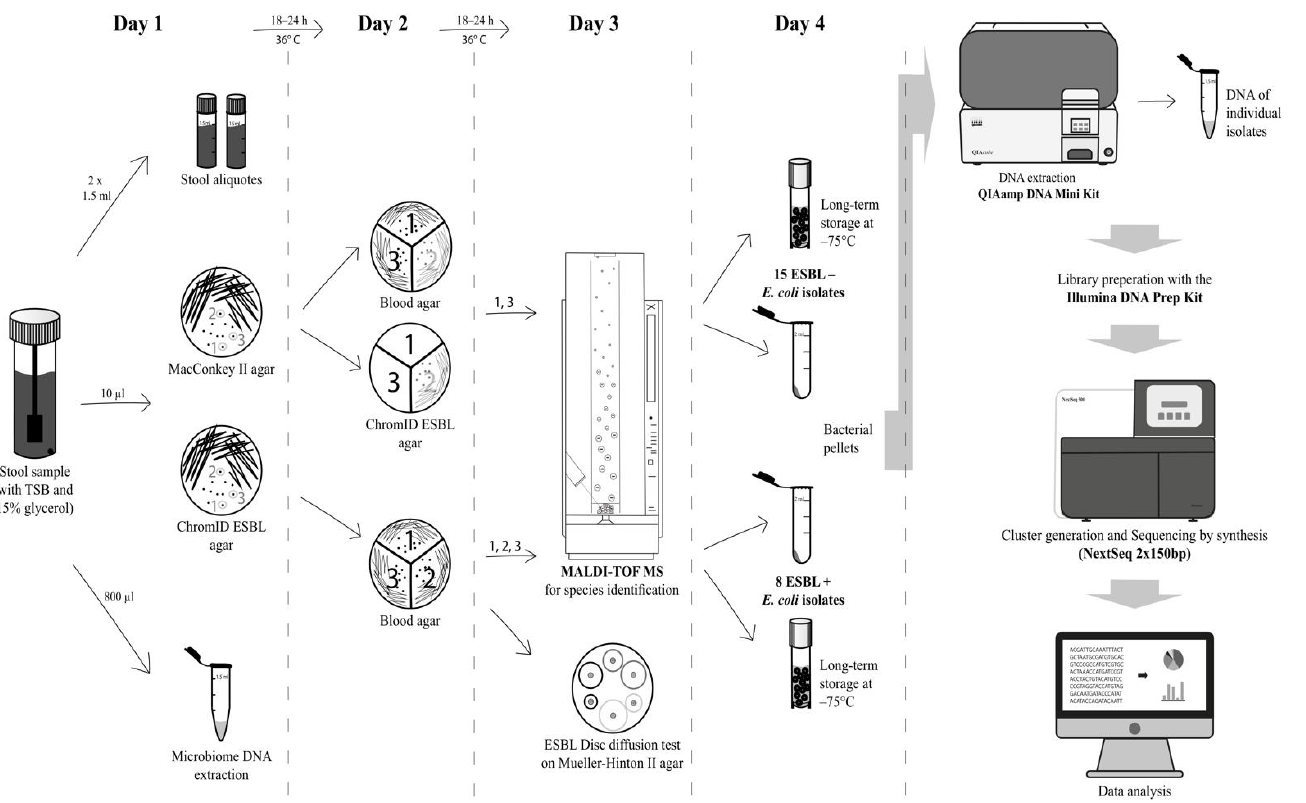
Figure 2. Microbiological processing of samples (see Supplementary File 6).